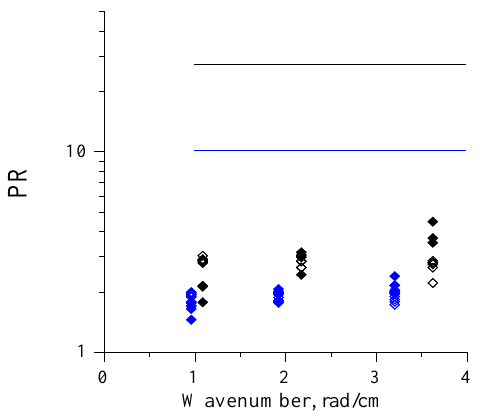
Figure 4. PR for crosswind observations at incidence angles of 50 ◦ (blue symbols) and 60 ◦ (black